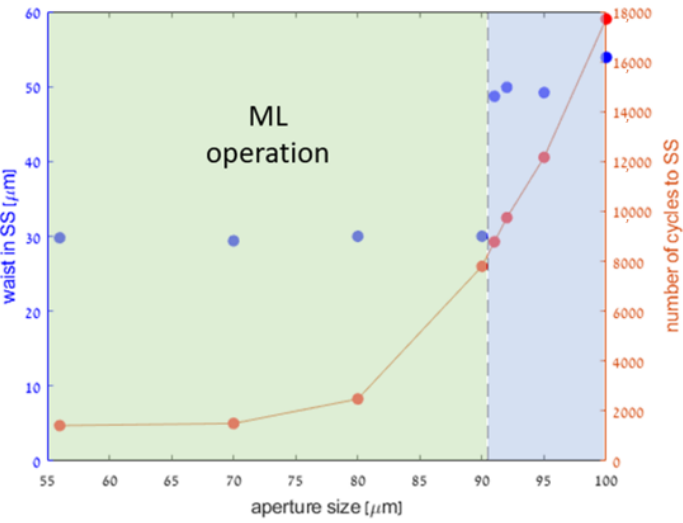
Figure 8. Artificial aperture for numerical convergence. In order to maintain a reasonable beam size during all stages of the simulation, we implemented an artificial aperture to prevent the beam size from diverging during the initial stage of cavity amplification, when the intra-cavity power is too low to support a significant Kerr lens. This aperture was implemented as a lens with an imaginary focus, which is equivalent to a Gaussian aperture that limits the beam width, but keeps its total energy. To verify that the aperture does not affect the ML results, we ran the simulation for various artificial aperture sizes, recording the beam waist at steady state ( left axis ), as well as the number of round trips required to reach steady state ( right axis ). Note that within the convergence range (green background), the actual beam waist in steady-state is not affected by the artificial aperture. The run-time, however, diverges for wider aperture sizes until the algorithm stops converging at